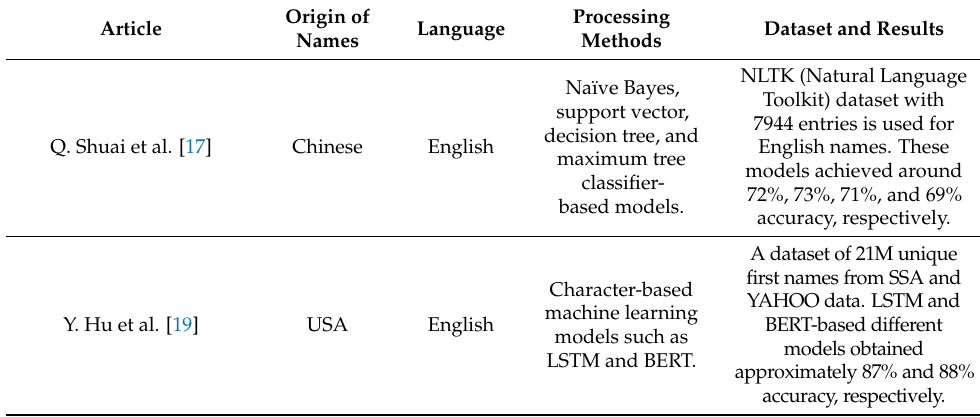
Table 1. Summary of the literature